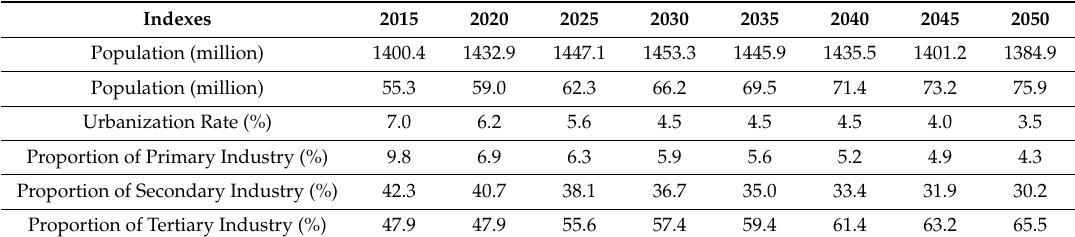
Table 1. Basic assumptions of the